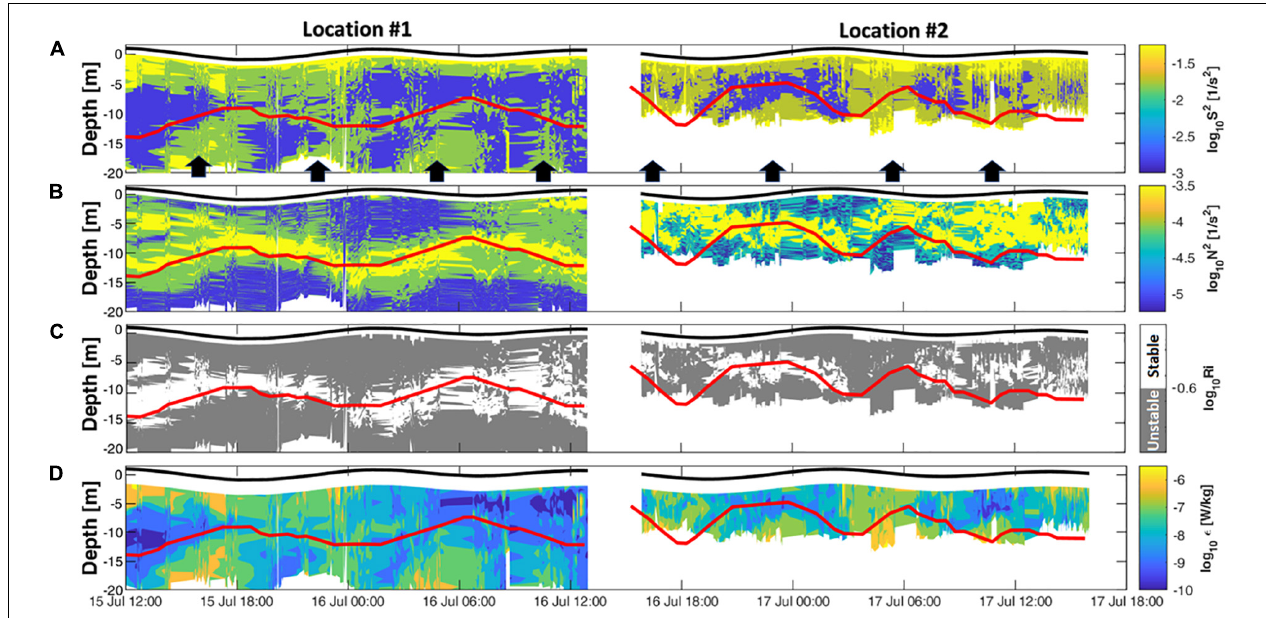
FIGURE 7 | Micro-CTD measurements at locations #1 and #2. (A) Measured current shear overlaid with black arrows indicating periods of increased vertical shear in the lower layer. (B) Buoyancy frequency. (C) Ri number [gray indicates instability ( Ri c > R i )]. (D) TKE dissipations. Solid red lines indicate the pycnocline